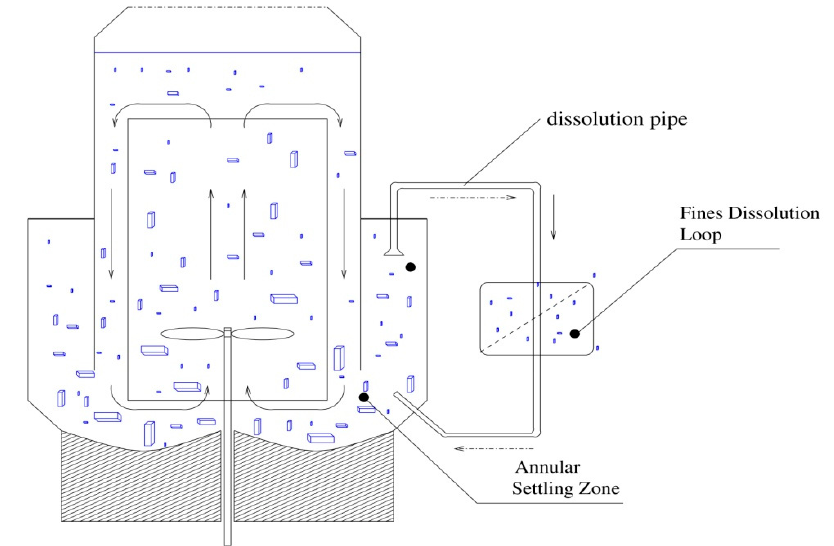
Figure 1. Single batch setup process with fines dissolution.